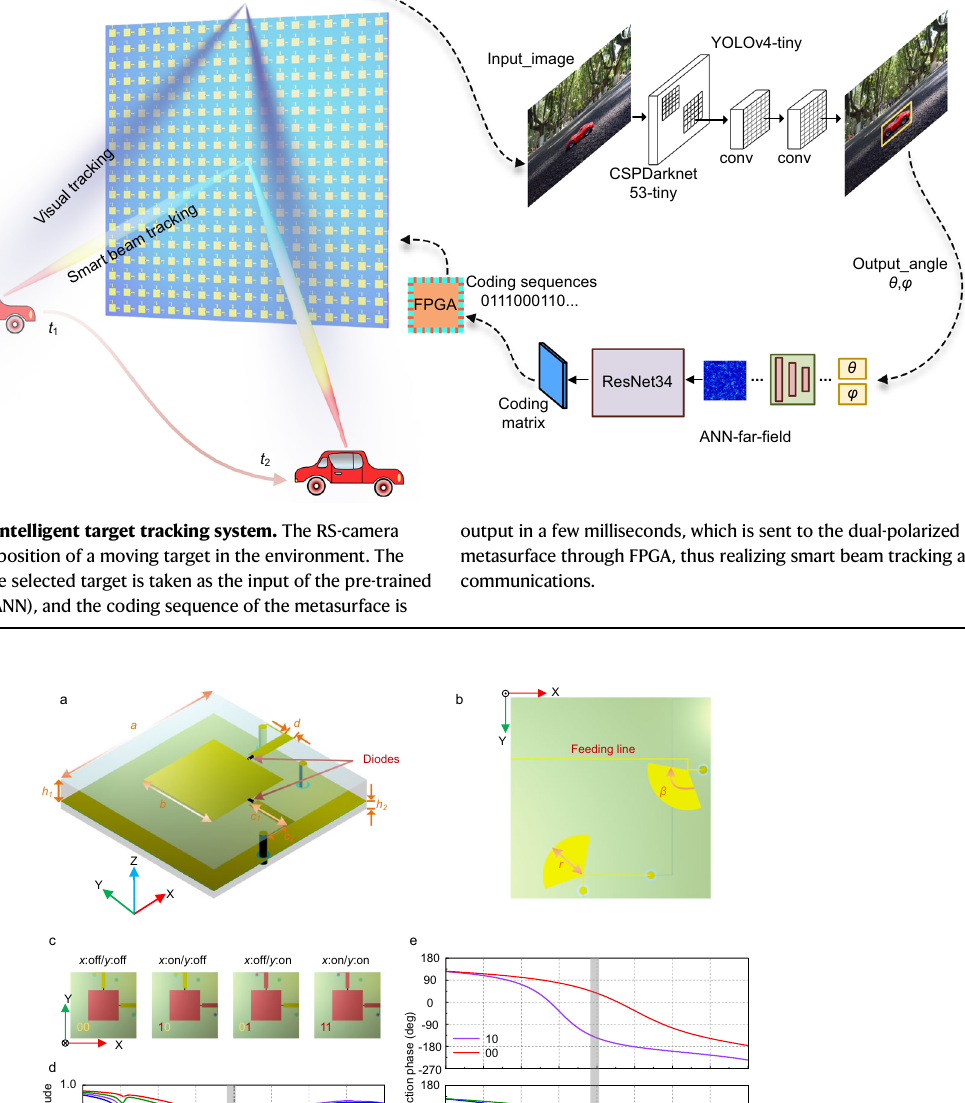
transmission schematic for the presented metasurface structure, including four switching schemes with two diodes. d , e The re fl ected magnitude and phase responses of the coding element when the PIN diodes are switched on and